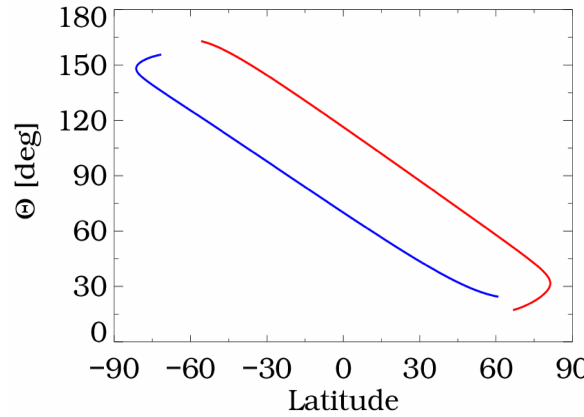
Figure 4. Variation of scattering angle ( (cid:50) ) vs. latitude for OMPS/LP measurements on 22 June (red) and 22 December (blue). (From Loughman et al.,